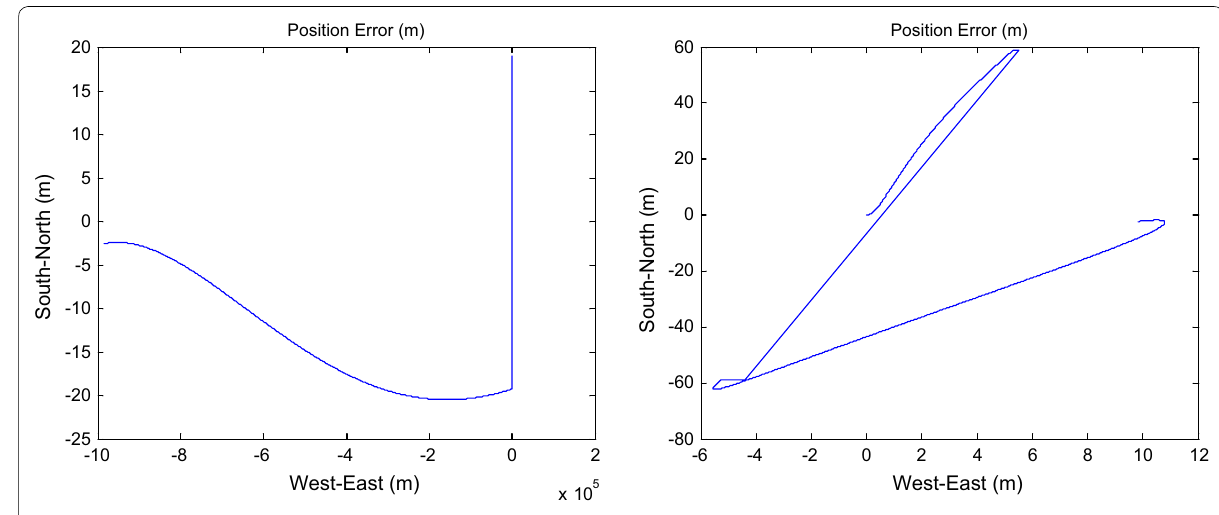
Fig. 4 Polar position errors of local-level-frame (left) and Earth-frame mechanizations